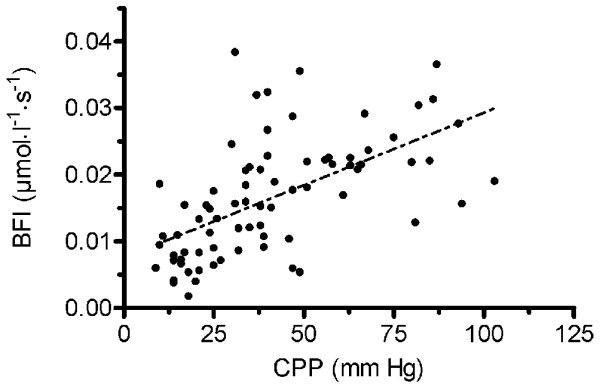
Correlation between cerebral perfusion pressure (CPP) and blood flow index by near infrared spectroscopy. r = 0.66, p < 0.0001. n = 76 measurements in 20 animals.